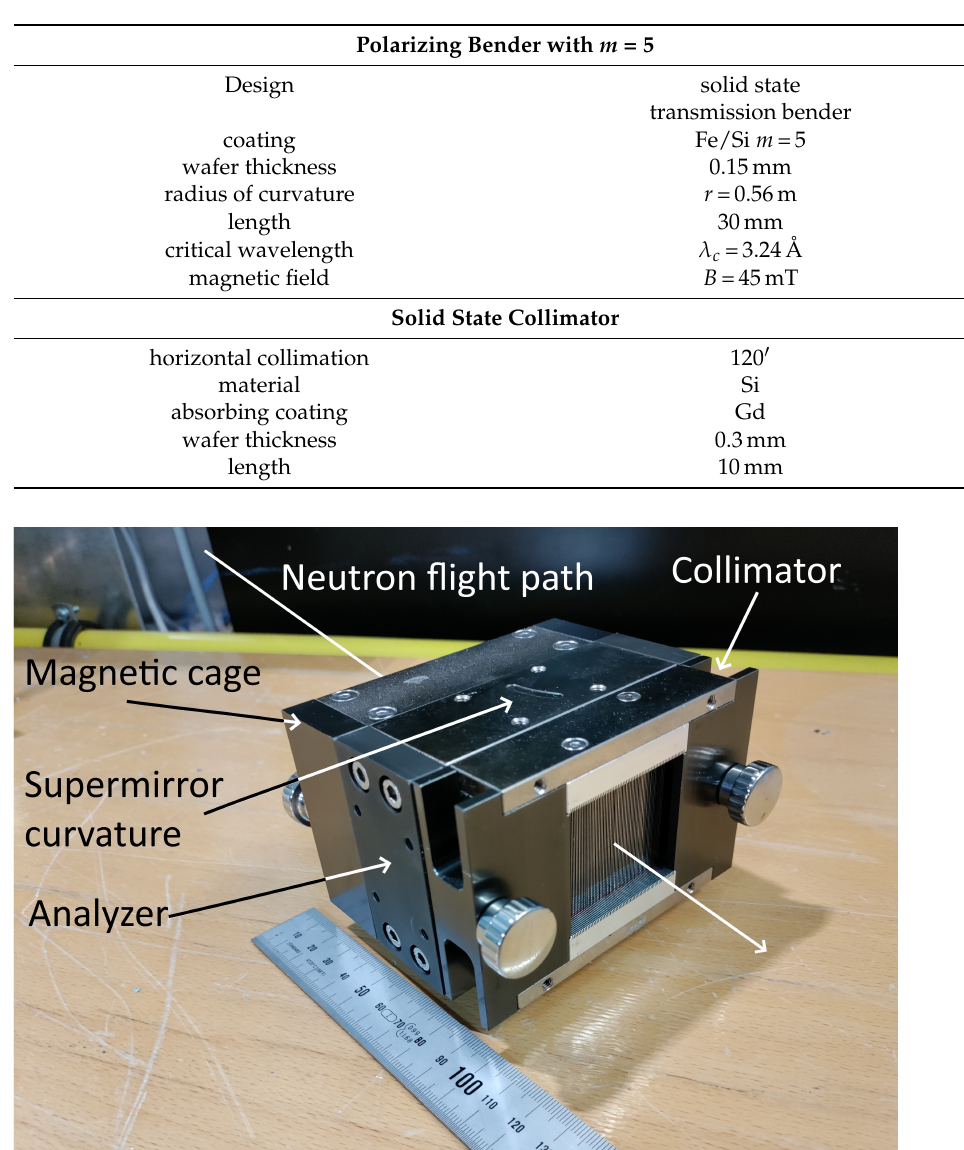
Figure 2. Photograph of the transmission bender used at RESEDA. The magnetic cage, a symbol indicating the curvature of the supermirror, analyzer, and collimator are indicated. The magnetic cage, analyzer, and collimator are sandwiched and held in position by long screws to ensure the stability of the setup. The magnetic cage and the collimator can be removed and/or replaced by a different